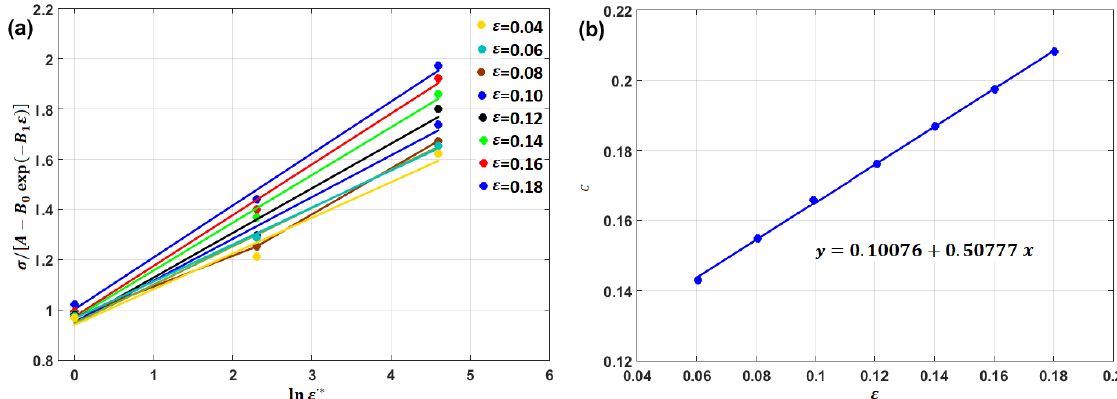
Figure 21. Determination of 𝐶 1 and 𝐶 2 : ( a ) 𝜎/[𝐴 − 𝐵 0 𝑒𝑥𝑝(−𝐵 1 𝜀)] vs. 𝑙𝑛 (𝜀 ∙∗ ) to obtain 𝐶 values and ( b ) 𝐶 vs. 𝜀 to obtain 𝐶 1 and 𝐶 2 . ( b ) C vs. ε to obtain C 1 and C 2 .